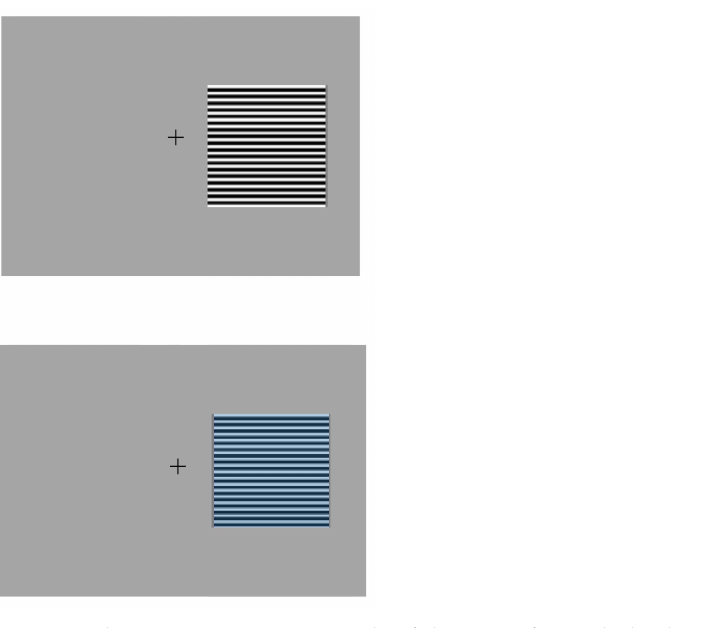
Figure 1. The top image is an example of the type of stimuli displayed in the first phase of the experiment: spatial frequency selection. The bottom image is an example of the type of stimuli used in the second phase of the experiment where each participant’s most uncomfortable spatial frequency was rated when ‘overlain’ with 10 different colours from Wilkin’s Intuitive